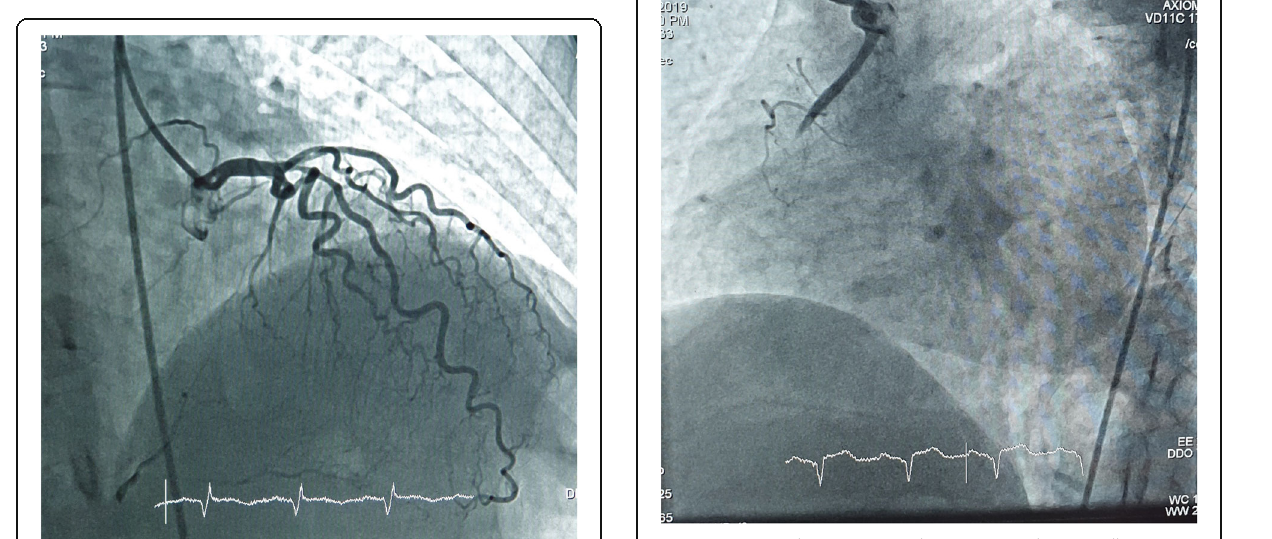
Fig. 3 LAO view showing anomalous origin and proximally cutoff